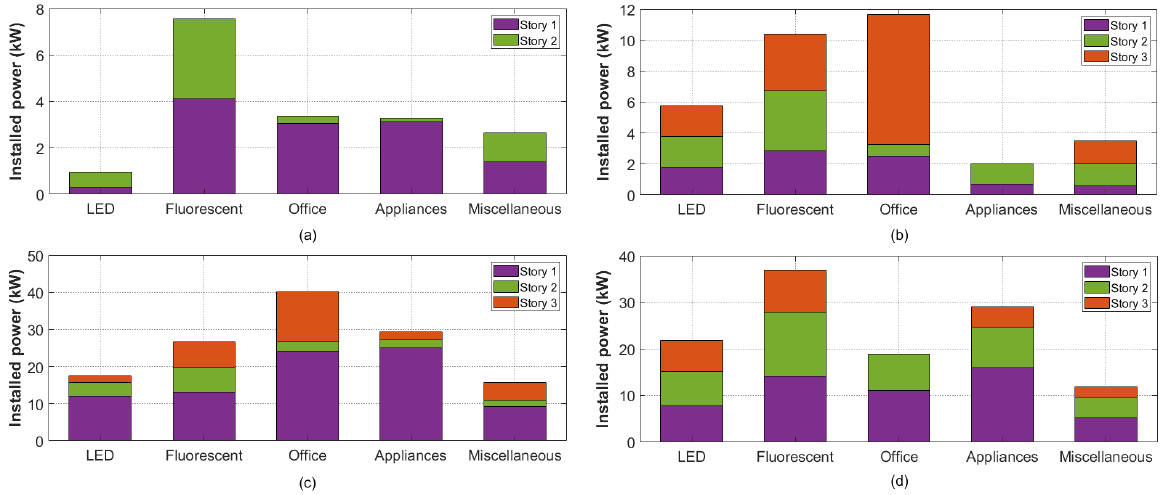
Figure 4. Lighting and plug loads. Installed power in ( a ) Building 1, ( b ) Building 2, ( c ) Building 3, and ( d ) Building